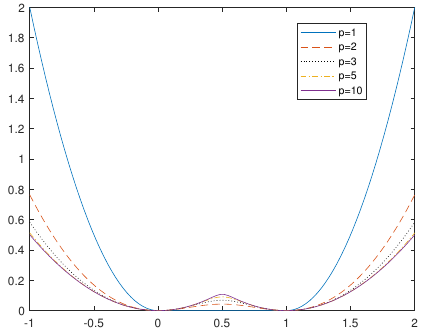
Figure 2. Graphs of σ p